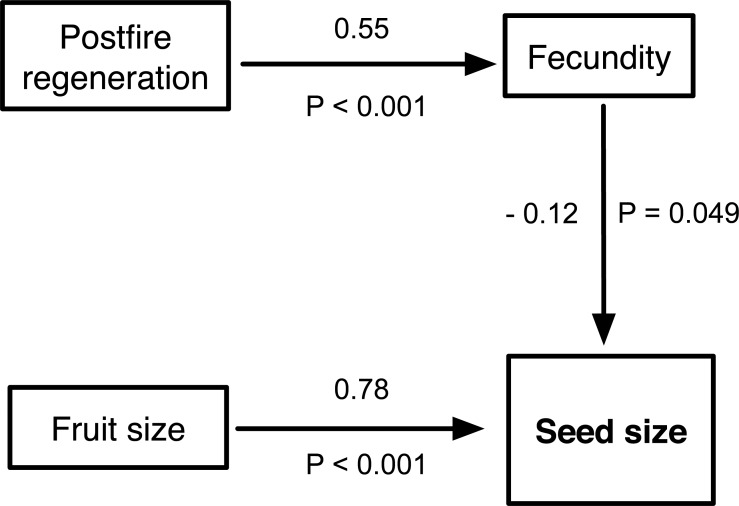
Simplified structural equation modelling analysis showing the significant interacting pathways between seed size, fecundity, postfire regeneration strategy and fruit size.Numbers above the lines are the standardised direct effects.